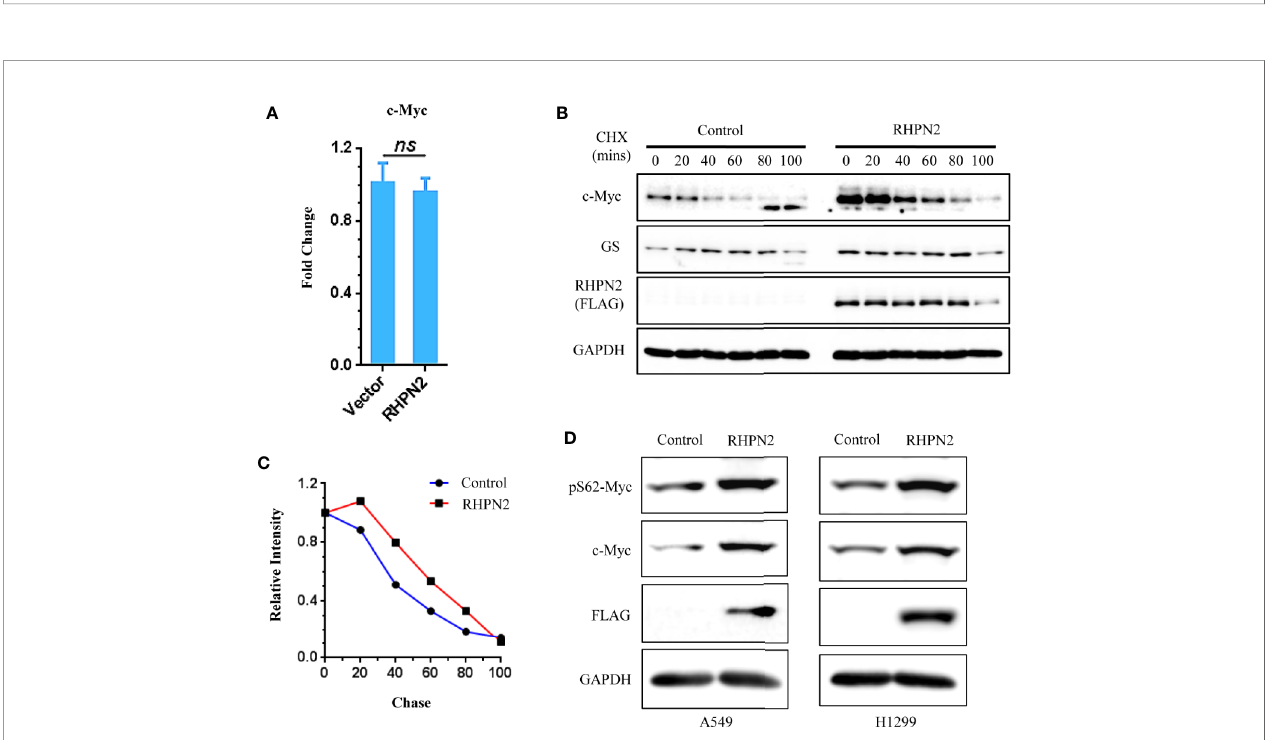
FIGURE 7 | RHPN2 stabilizes c-Myc protein. (A) RT-qPCR analysis of expression of MYC in A549 cells expressing RHPN2. (B) CHX chase assay analysis of c-Myc degradation in A549 cells expressing RHPN2 or vector control. (C) Quanti fi cation of the levels of c-Myc normalized by the intensity of GAPDH in (B) using ImageJ. (D) Immunoblotting analysis of the expression of c-Myc and pSer62-Myc in A549 and H1299 cells expressing RHPN2 or vector control. ns, not signi fi cant.